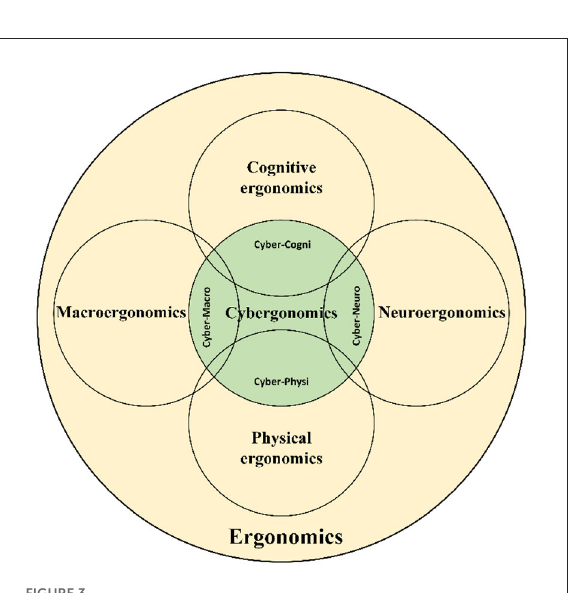
FIGURE3 Independent and joint research framework for